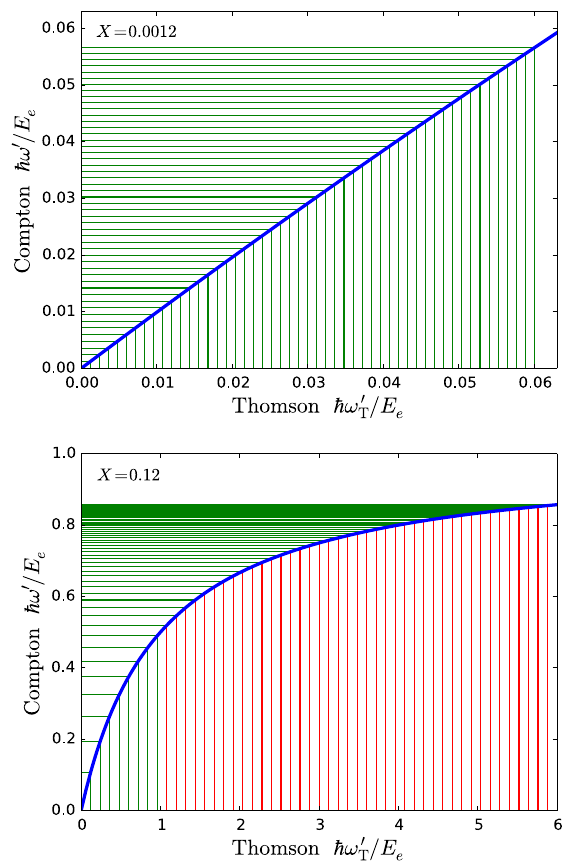
FIG. 1. Relationship between the scattered frequencies in Compton and Thomson regime (blue line), including the first 50 harmonics for X ¼ 0 . 0012 (top panel) and X ¼ 0 . 12 (bottom panel). Harmonics in the Thomson regime which are at higher energies than the rms electron energy ℏ ω 0 and are marked in red. The physical harmonics are shown in